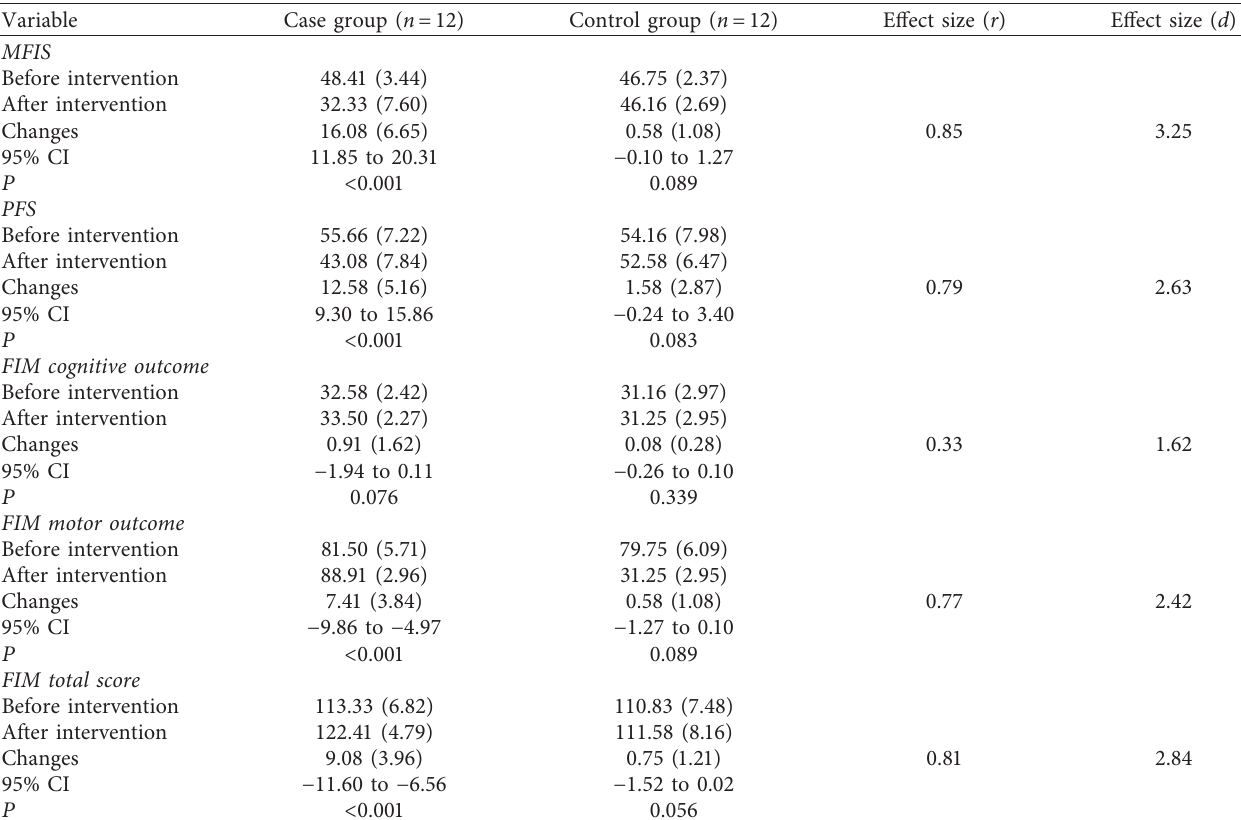
Table 2: Fatigue and functional independence in daily activities before and after the interventions (at the end of 24 th